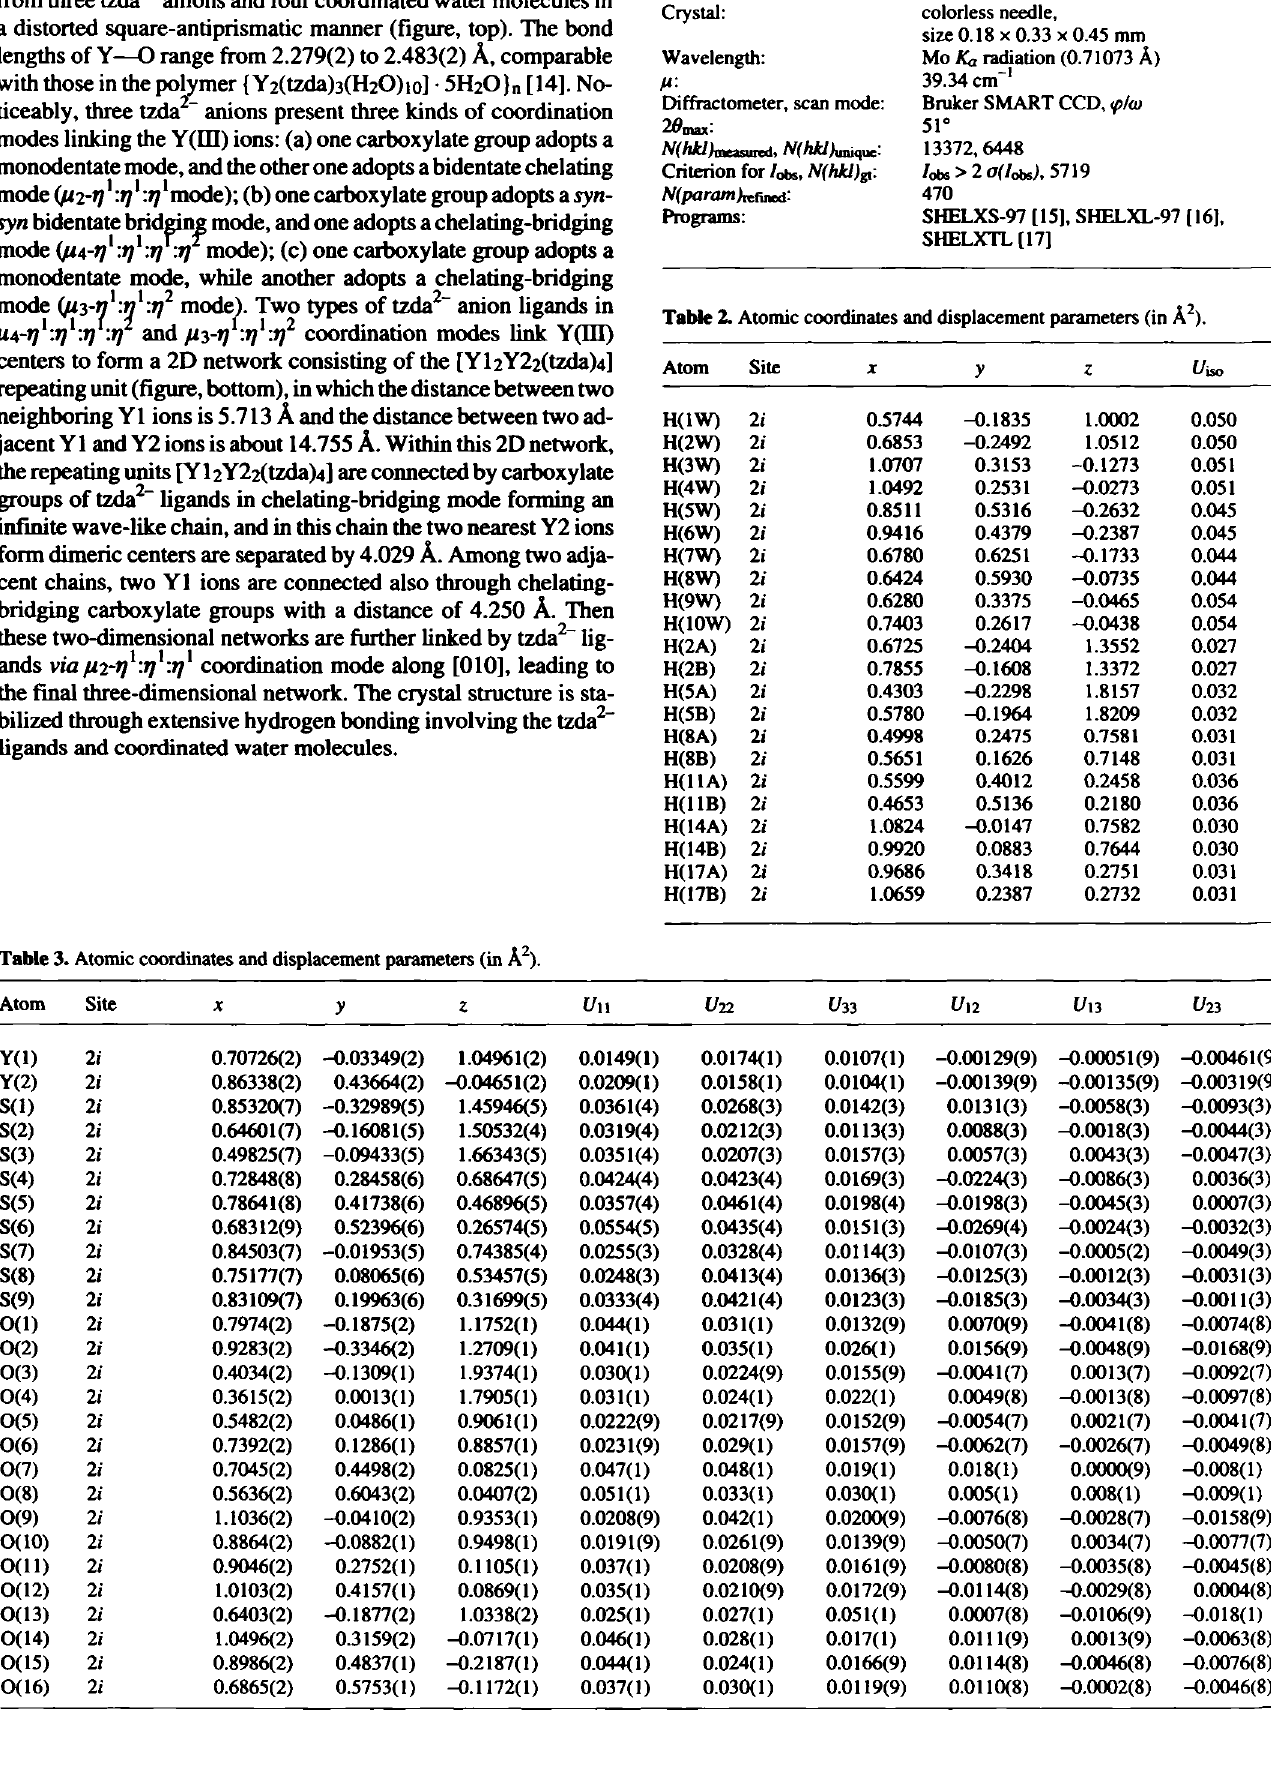
Table 2. Atomic coordinates and displacement parameters (in Â 2 ).